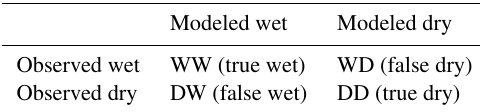
Table 1. Flood comparison confusion